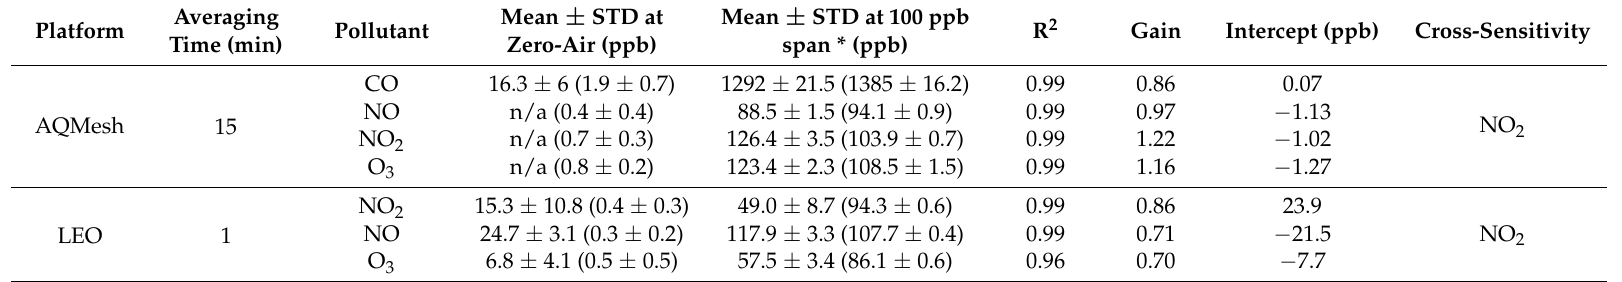
Table 5. Performance of the EC sensor in the lab ( n = 3). In parenthesis are the simultaneous reference measurements.